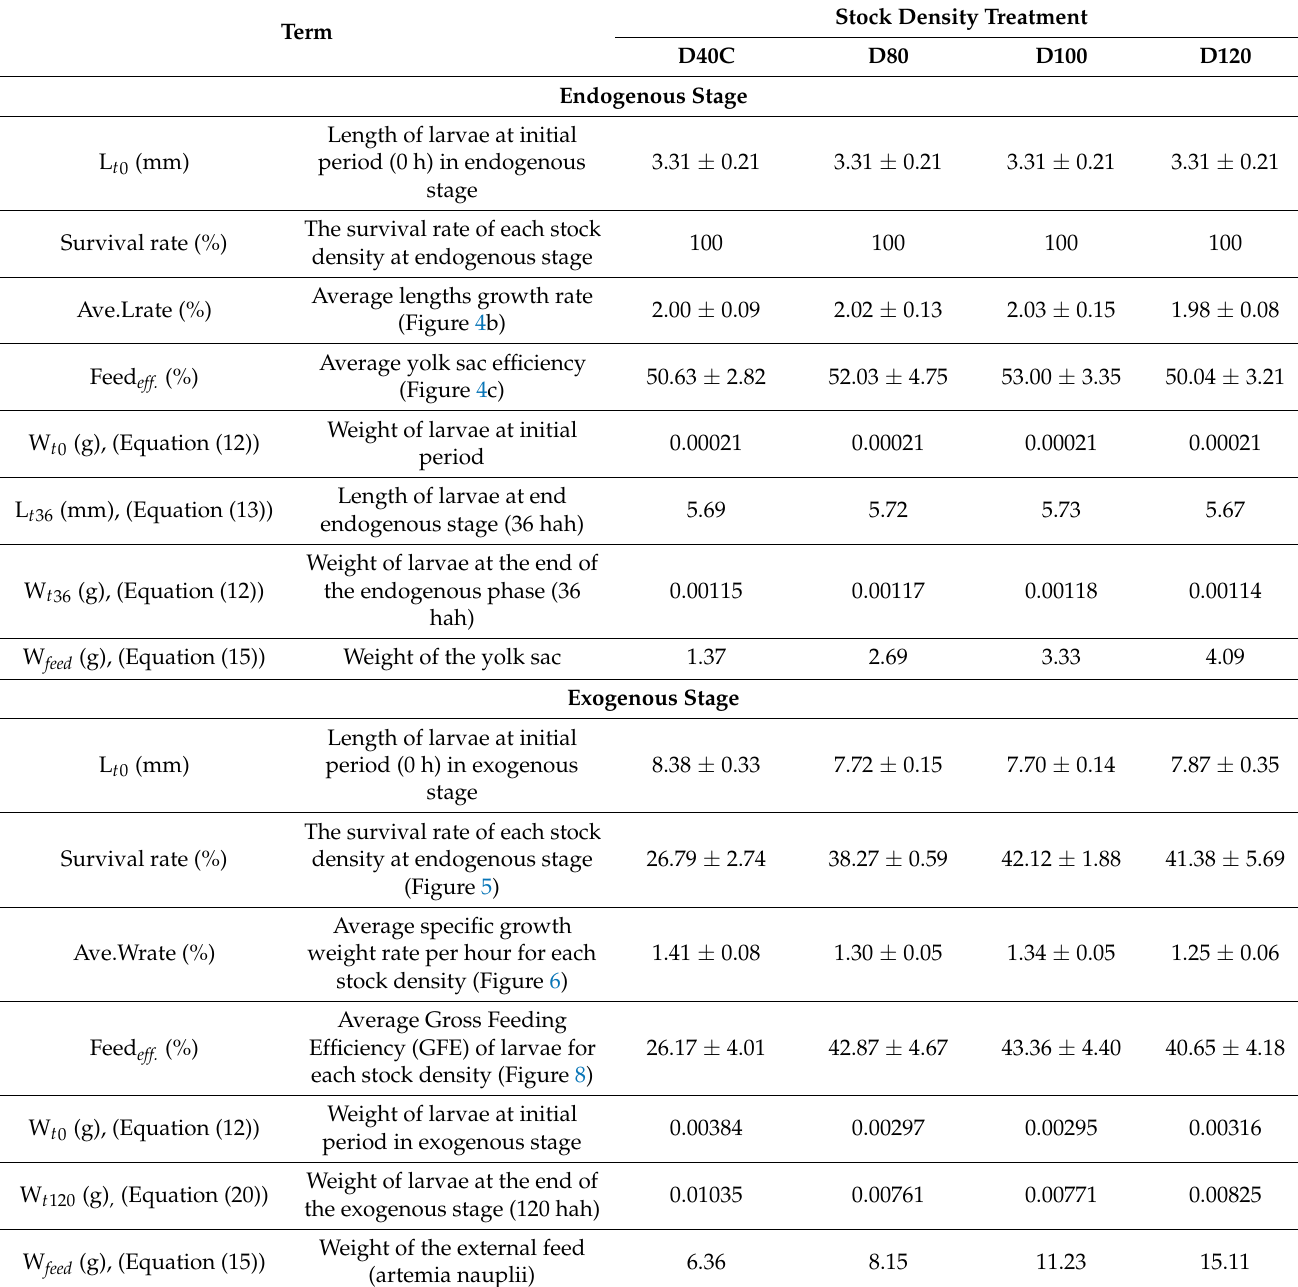
Table 4. The variable and terms for calculating the unionized ammonia production in FBs-RAS at the endogenous and exogenous stages of striped catfish ( Pangasianodon hypophthalmus